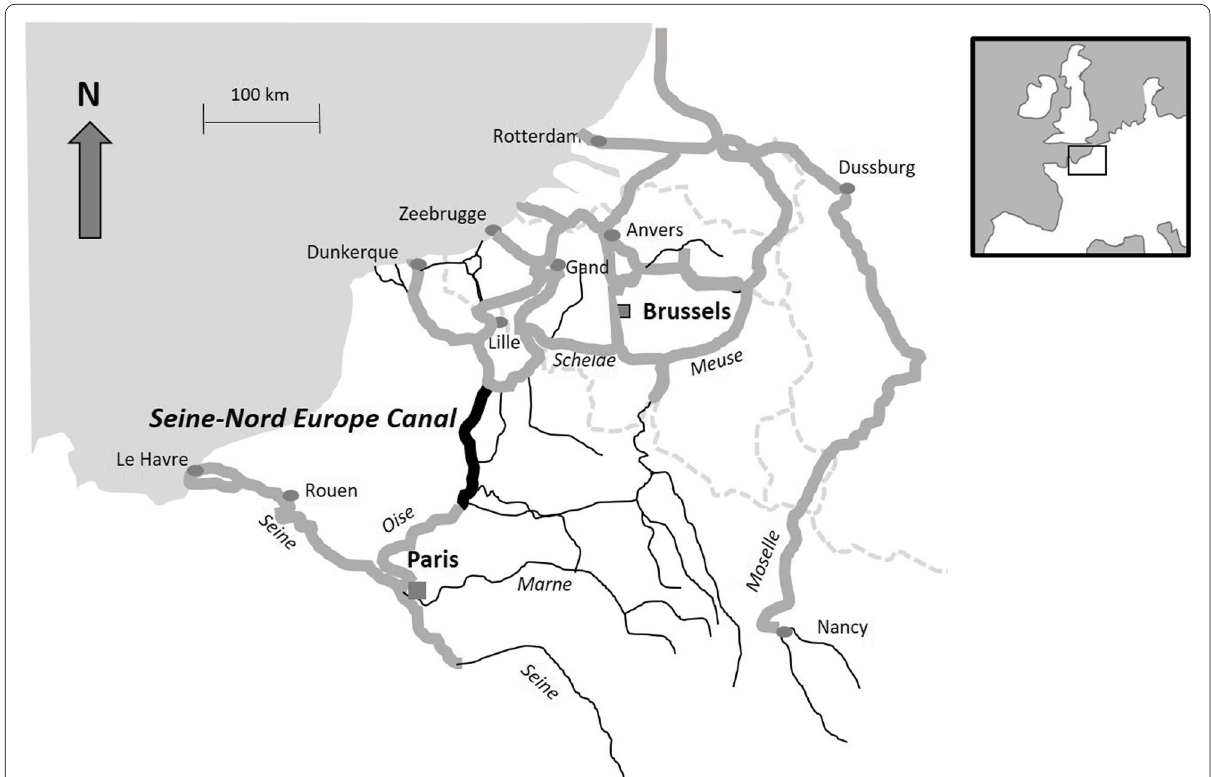
Fig. 1 General map of the location of the Seine Nord Europe Canal project and among North-Atlantic waterways. Source: Authors, adapted from https:// www. canal- seine- nord- europe. fr/ Objec